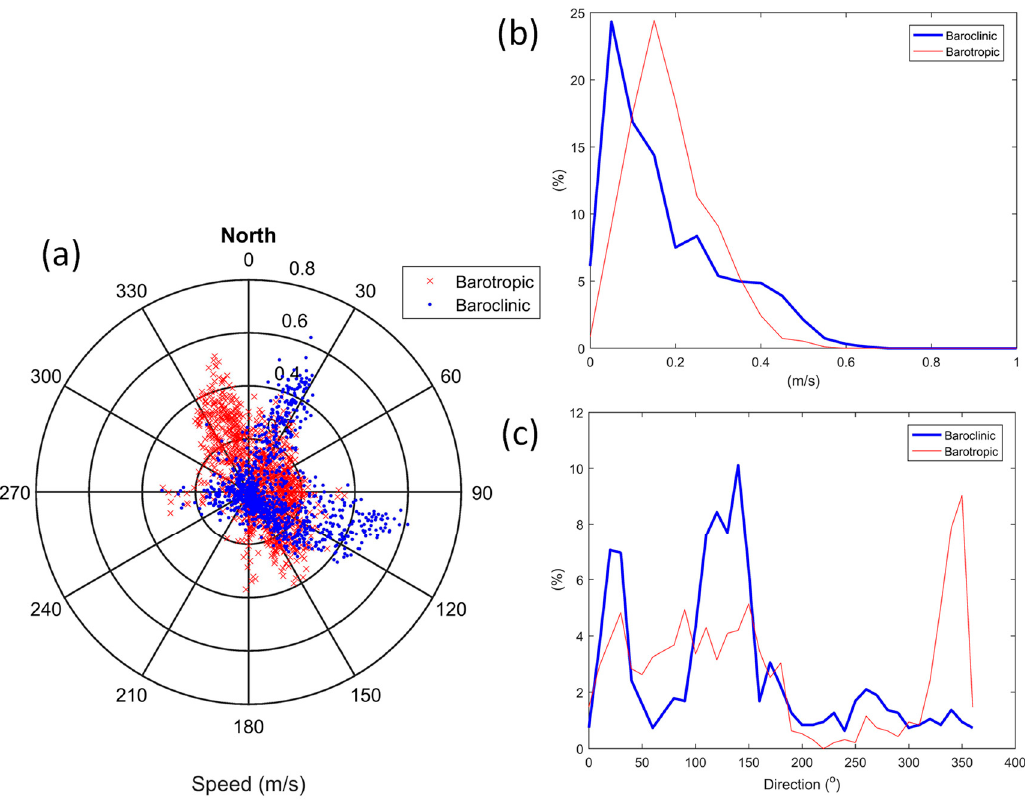
Figure 16. ( a ) Model-derived near-bottom ocean current vectors at 196 m from referential barotropic model results (red crosses), compared with baroclinic model results (blue dots) between 1 November and 31 December 2014. Associated probability density function of current speeds ( b ) and directions ( c ) derived from the barotropic (blue lines) and baroclinic model results (red lines) are also compared.